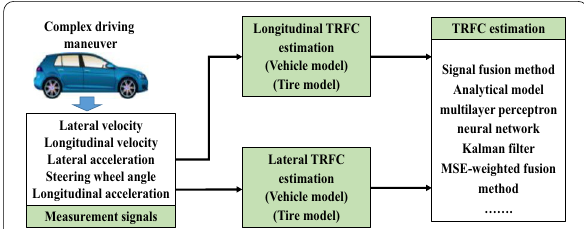
Figure 5 The general framework of the hybrid estimator